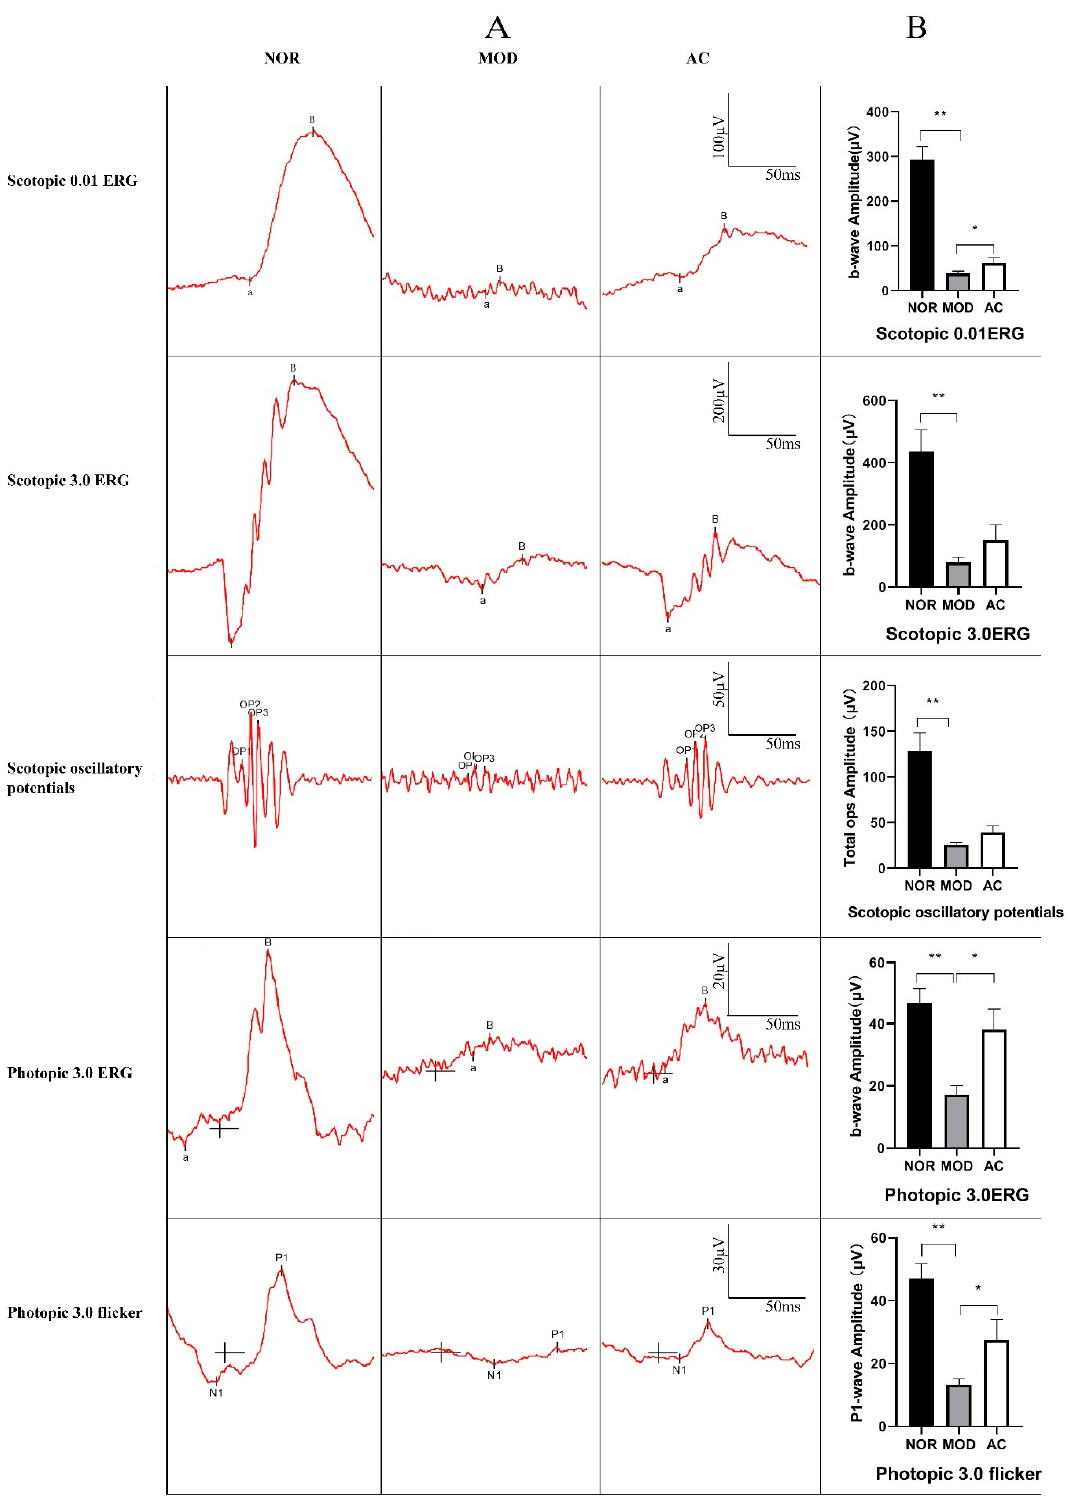
Figure 2. Full-field electroretinograms of the rats by different treatments. Rats from each group were anesthetized and analyzed by electroretinograms (ERGs). ( A ) Full-field ERGs were recorded on the 21th day after NaIO 3 injection. ( B ) The averages of the three groups of b-wave amplitudes of Scotopic 0.01 ERG, Scotopic 3.0 ERG, and Photopic 3.0 ERG and total amplitude of Scotopic 3.0 oscillatory (3 ops) and P1-wave amplitude. Data of b-wave amplitudes shown are the mean ± standard deviation (n = 12). (*) p < 0.05, (**) p < 0.01 (one-way ANOVA followed by Tukey’s test).